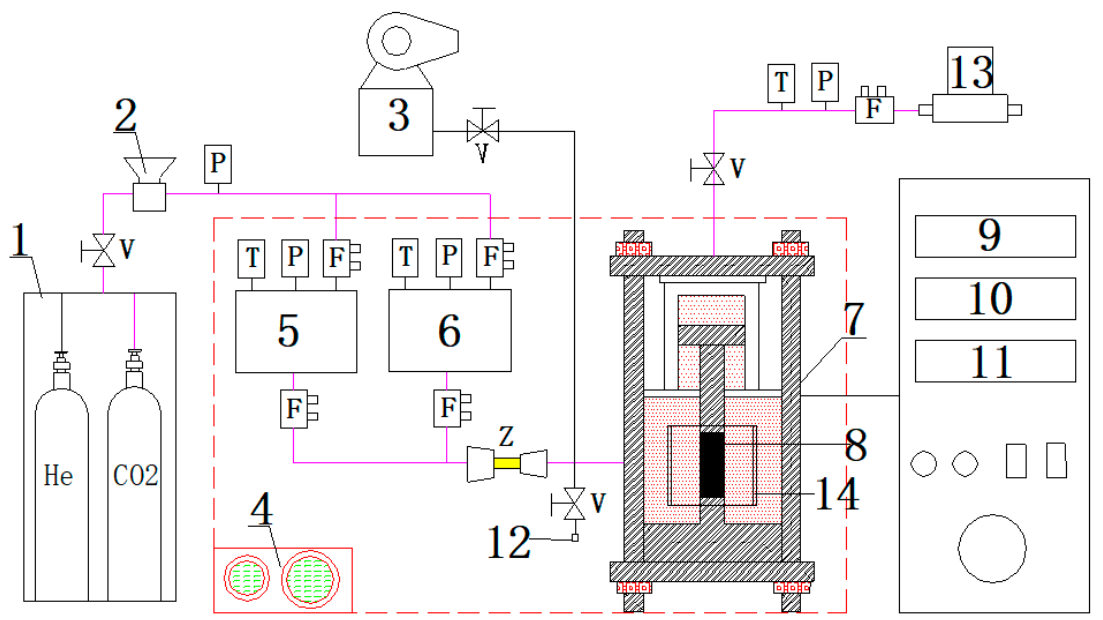
Figure 2. The schematic diagram of the tri-axial creep-seepage and adsorption-desorption experimental systems of coal and rock.